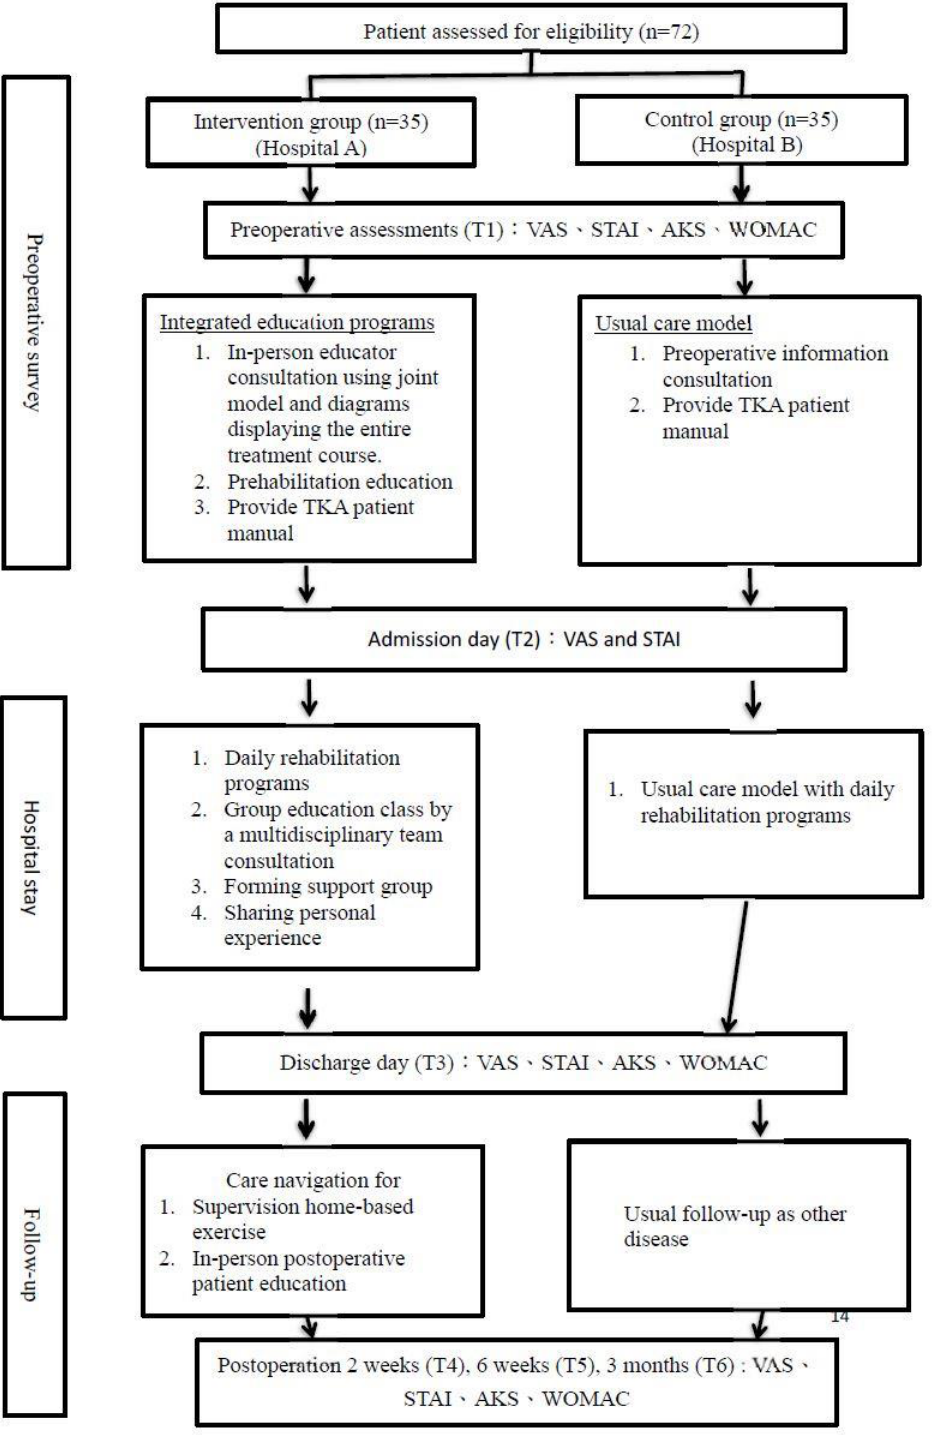
Figure 1. Detailed flowchart of the IEP (integrated education program).